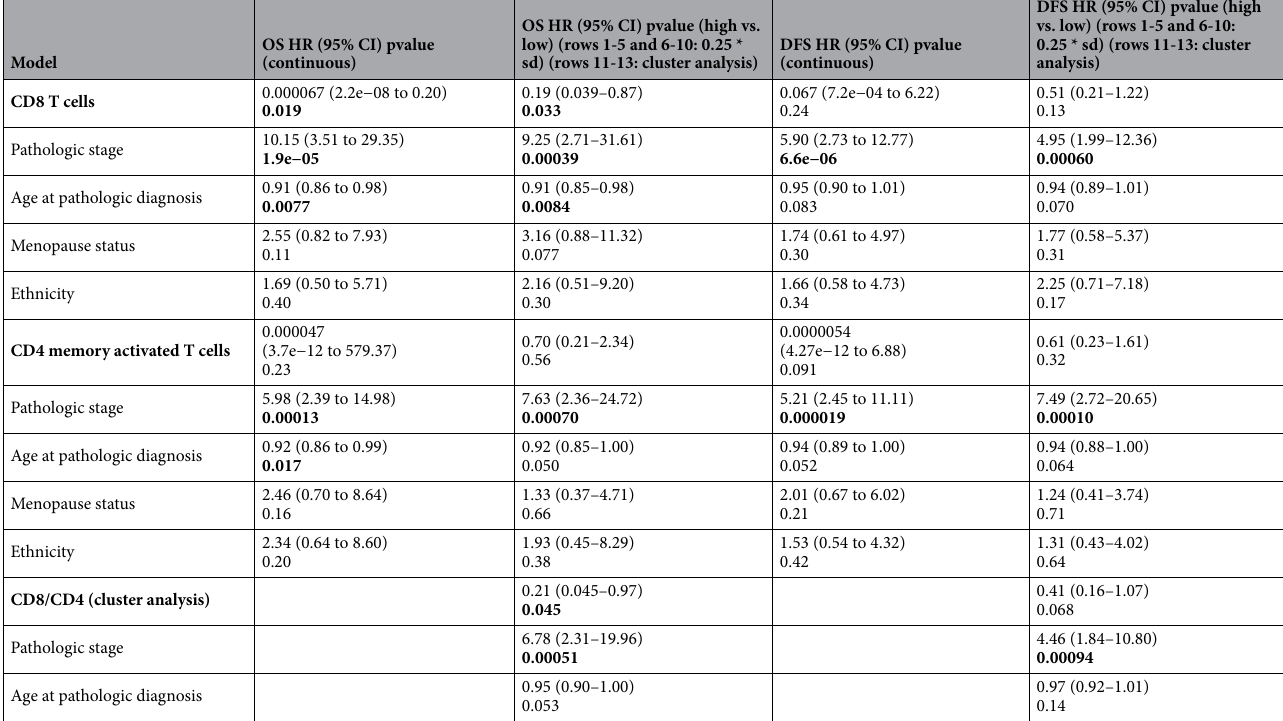
Table 3. Prognostic value of immune cell types in TCGA TNBC (multivariate). Bold : pvalue < 0.05. TCGA: The Cancer Genome Atlas; TNBC: triple negative breast cancer; OS: overall survival; HR: hazard ratio; CI: confidence interval; DFS: disease free survival; sd: standard deviation.